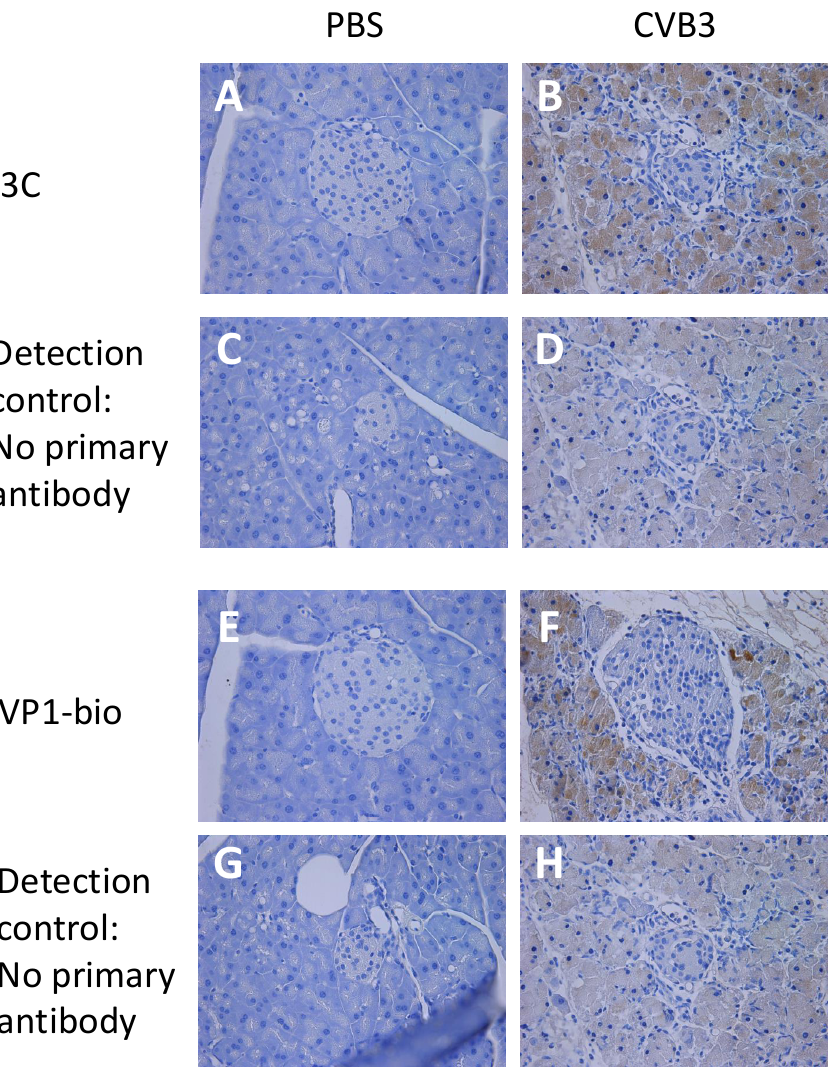
Figure 1. Viral 3C and VP1 proteins are expressed in murine pancreata following infection with Coxsackievirus B3 (CVB)3. C57BL / 6J mice were mock-infected with PBS ( A , C , E , G ) or infected with CVB3 (10 2 PFU / mouse) ( B , D , F , H ) for 3 days. Pancreas sections were stained with either an